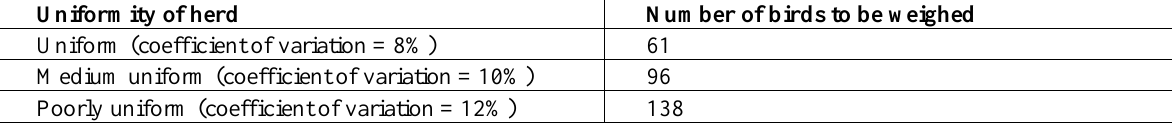
Table 3 Minimum number of birds for accurate assessment of live weight and herd uniformity [11] Uniformity of herd Number of birds to be weighed Uniform (coefficient of variation = 8%) 61 Medium uniform (coefficient of variation = 10%) 96 Poorly uniform (coefficient of variation = 12%)